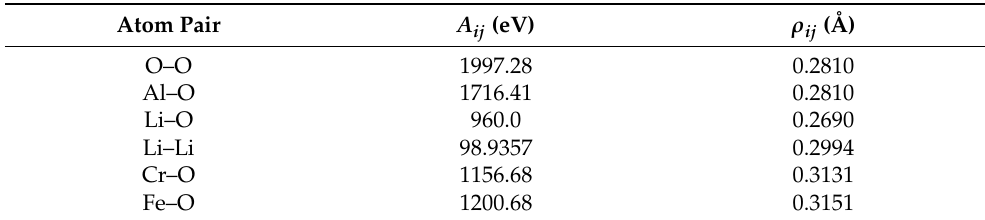
Table 1. Potential parameters, A ij and ρ ij , used in this work. Short-range repulsion was not considered for the cation pairs except